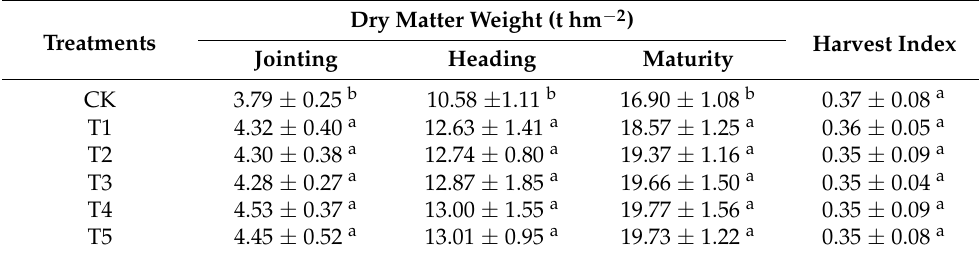
Table 2. Dry matter weight of rice under different ZnO NPs application amounts.